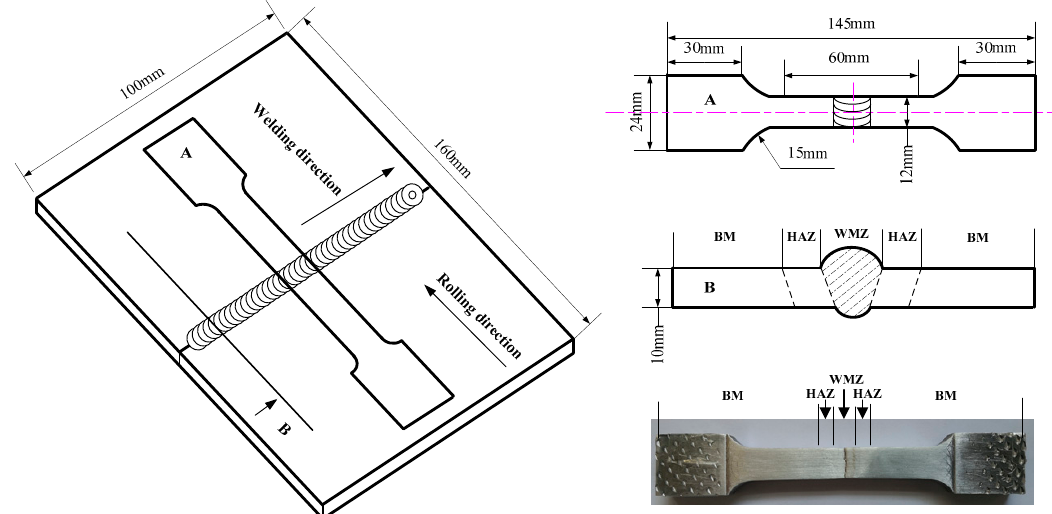
Figure 2. Schematic illustration of the welded joint and an indication of various zones across the weld. BM: base metal, HAZ: heat affected zone, WMZ: weld metal zone.